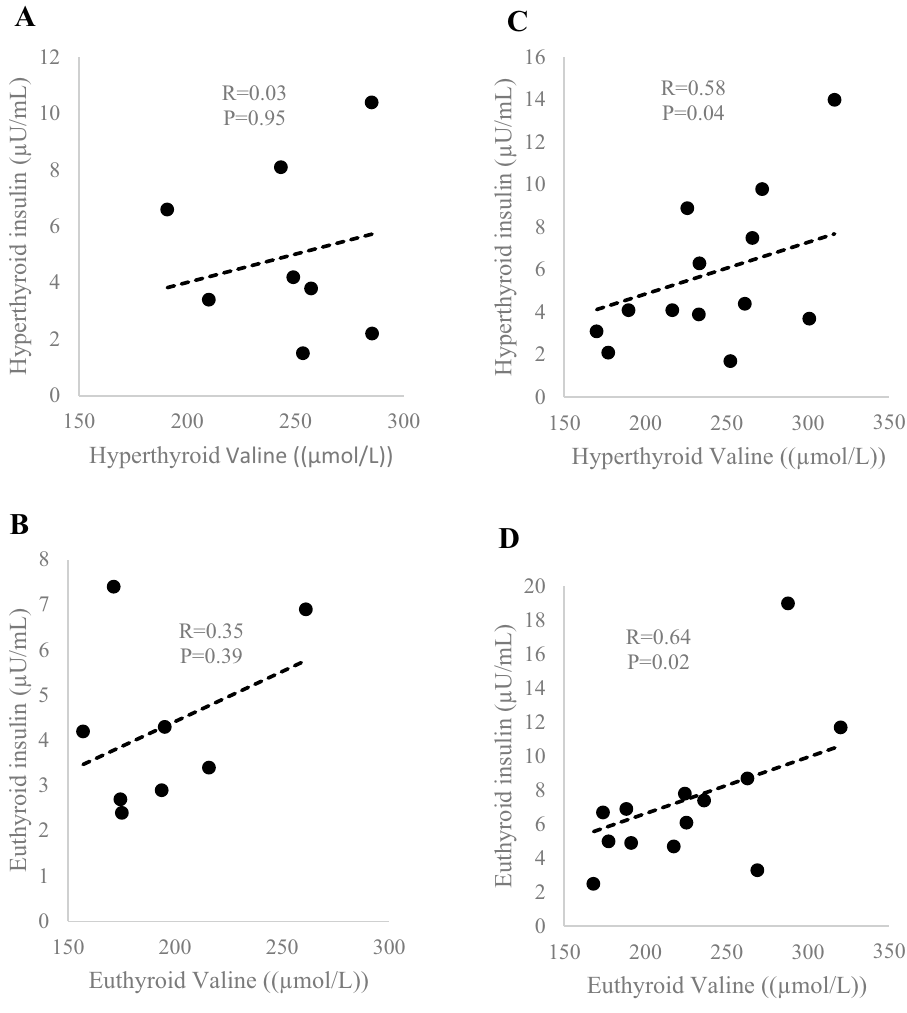
Figure 1. Correlations between valine concentration with insulin concentration at hyperthyroid state ( A) and euthyroid state ( B) in BAT-positive subjects and BAT-negative subjects ( C,D) . n = 8 in BAT-positive subjects; n = 13 in BAT-negative